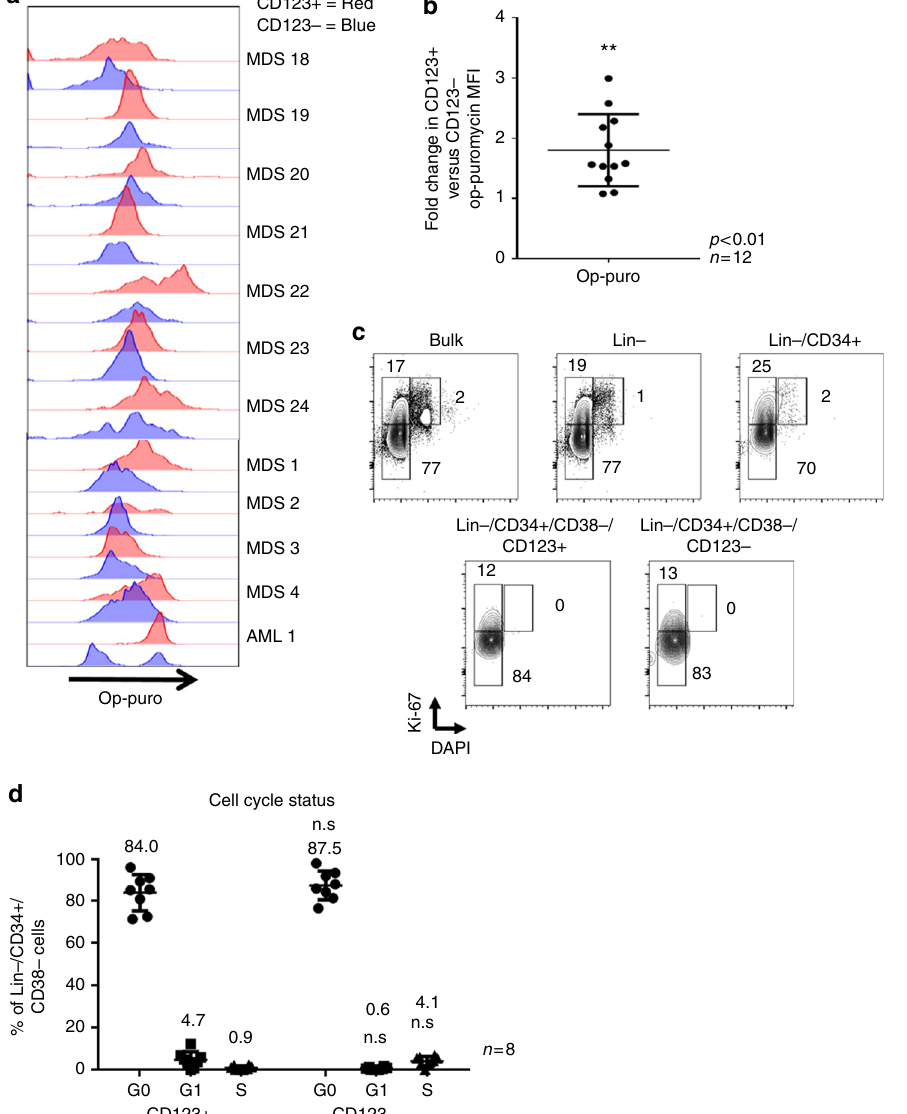
Fig. 3 CD123 + stem cells exhibit increased translation but no change in cell cycle status. a CD123 + cells(red histogram) vs. CD123- cells(blue histogram) from Lin − /CD34 + /CD38 − high-risk bone marrow specimens exhibit increased protein synthesis as measured by op-puromycin in 11 independent patient specimens b Ratio of the mean fl uorescence of CD123 + vs. CD123- cells shows an average 2-fold increase in CD123 + cells. c Cell cycle analysis of a representative MDS specimen (MDS 4) showing bulk, lin − , lin − /CD34 + and CD123 + /CD123 − stem cell populations. d Aggregate data comparing cell cycle in eight separate patient specimens shows no signi fi cant differences in CD123 + vs. CD123 − cells. ** p < .05 (two-tail t -test) error bars are